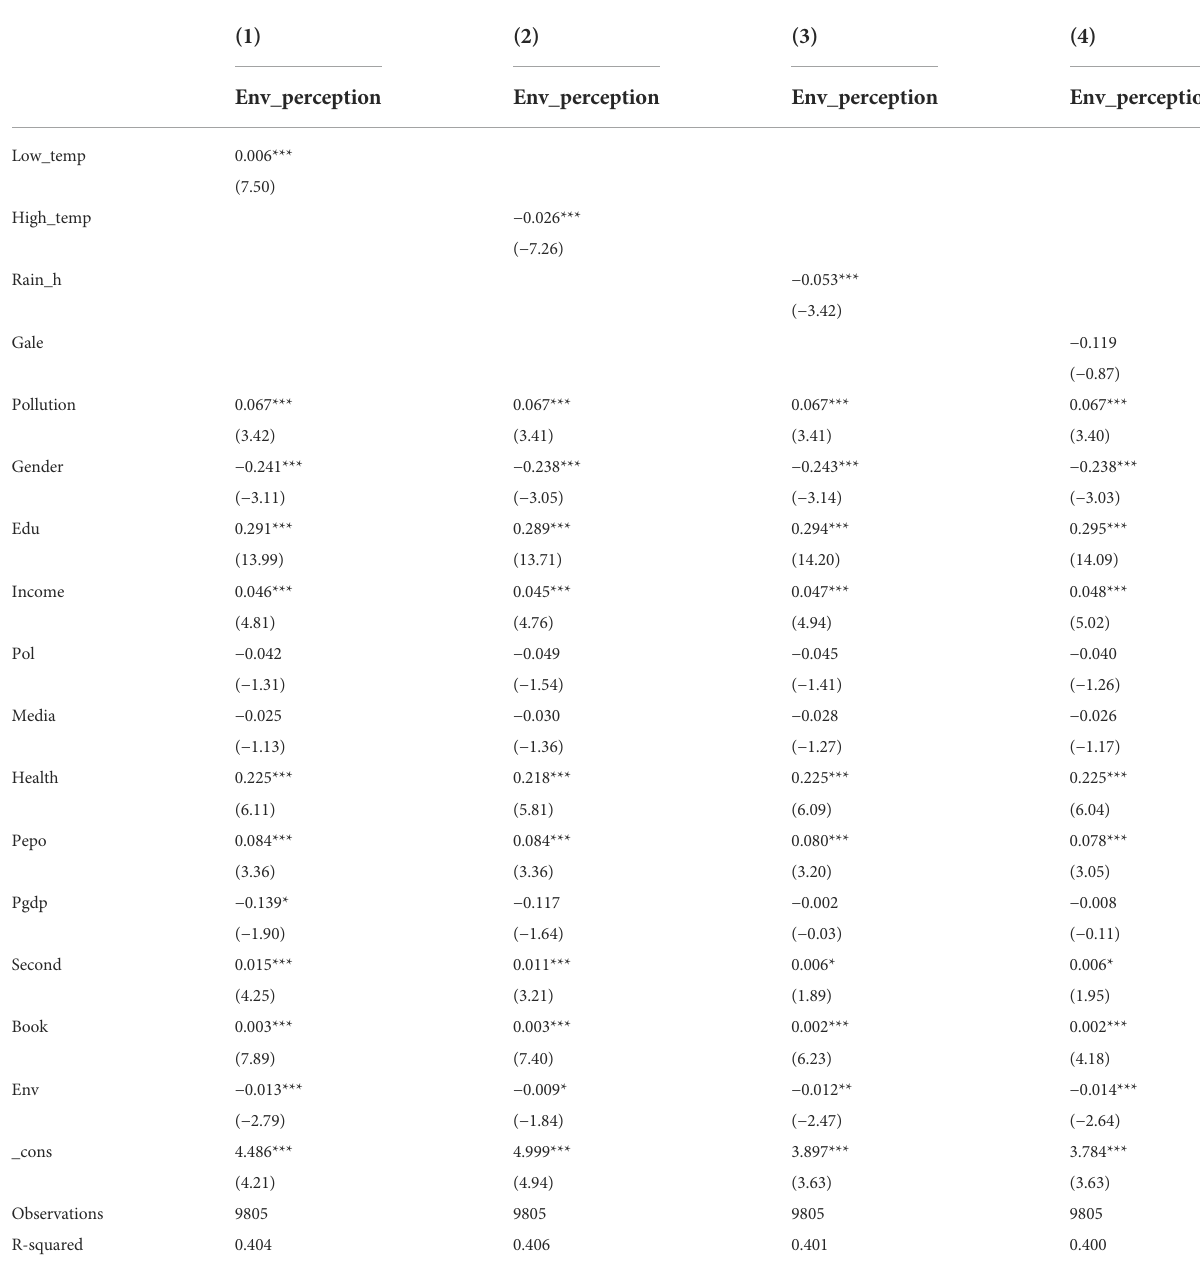
TABLE 12 Mechanism test — environmental